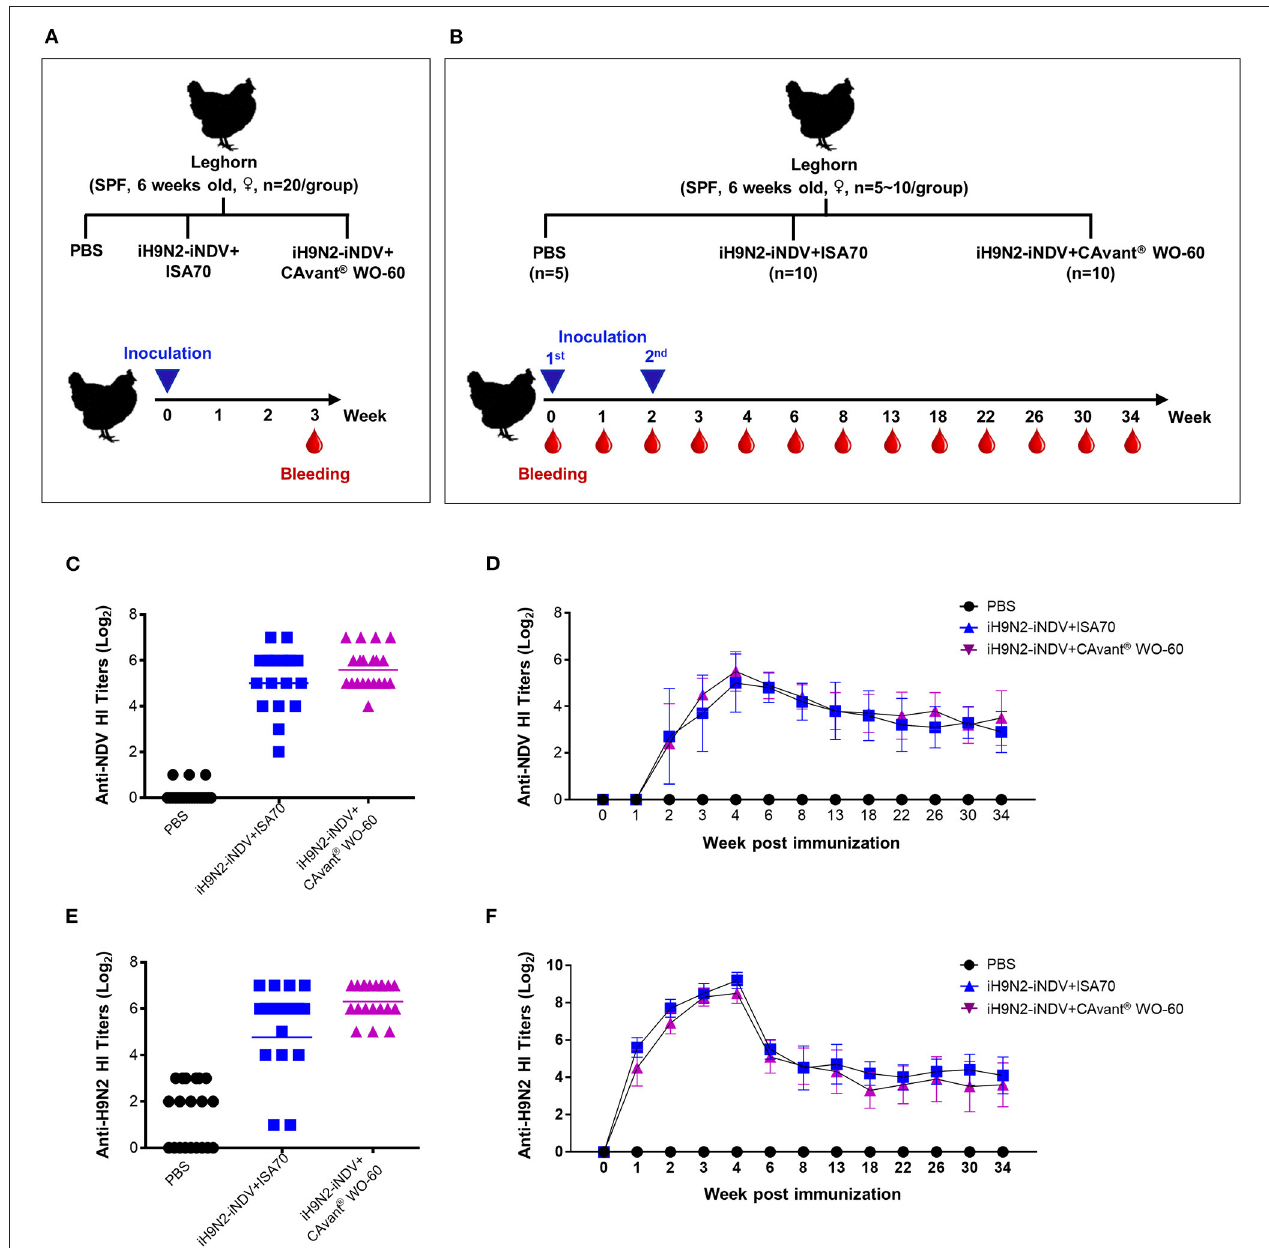
FIGURE 4 | Evaluation of the antigen-specific hemagglutination inhibition (HI) titers following immunization of chicken. (A,B) Schematic depiction of chicken experiment timeline. SPF chickens were intramuscularly immunized with one or two doses of bivalent iH9N2 and iNDV antigen either with ISA 70 VG or CAvant ® WO-60 adjuvant or PBS at weeks 0 and 2. Geometric means of hemagglutination inhibition antibody titers to NDV LaSota in immunized chickens with (C) one dose and (D) two doses of vaccine. Geometric means of hemagglutination inhibition antibody titers to H9N2 in immunized chickens with (E) one dose and (F) two doses of vaccine. Data presented as geometric mean (GM) of n = 20 and bar shows the mean ± SD of n = 10 or n = 5